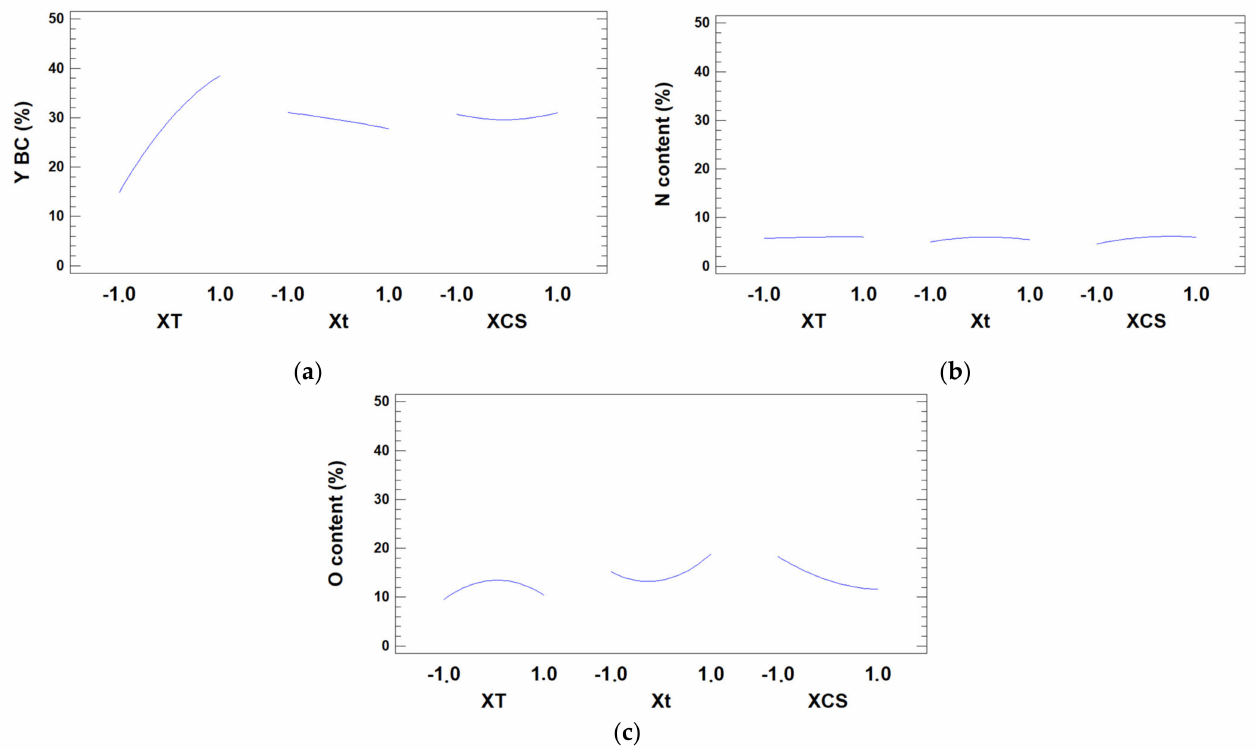
Figure 3. Effect of main factors on ( a ) biocrude yield, ( b ) nitrogen content in the biocrude and ( c ) oxygen content in the biocrude.